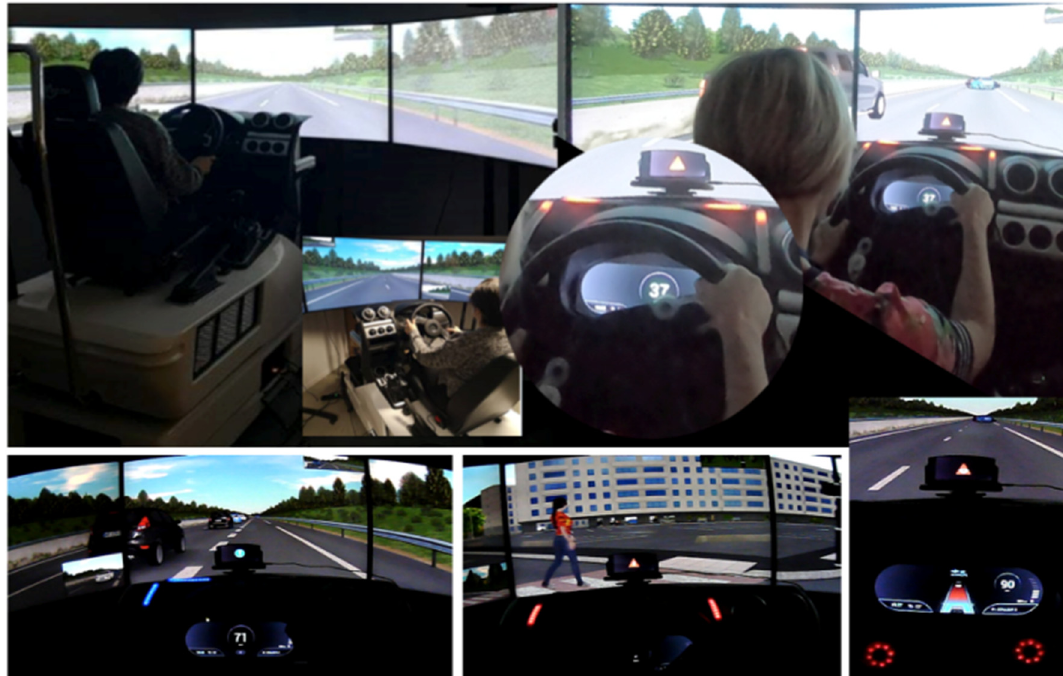
Figure 8. User experience tests as implemented on driving simulator.